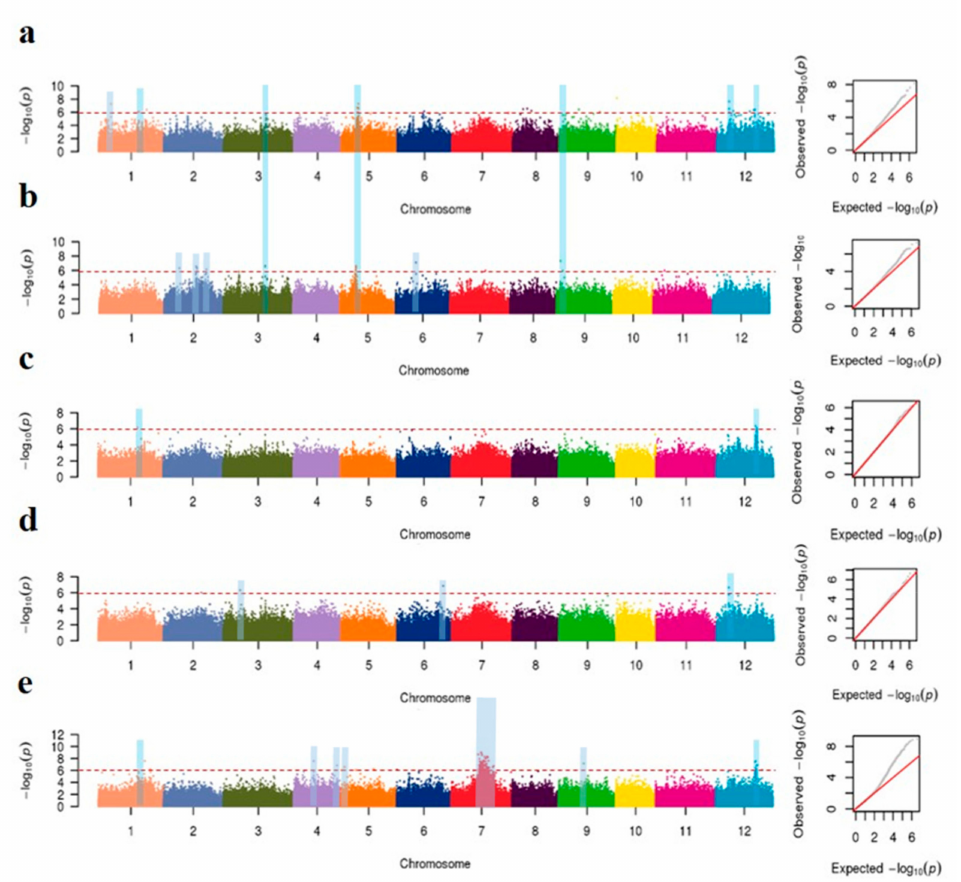
Figure 4. Genome-wide association studies for mesocotyl length among three culture media. Manhattan plots and Quantile-quantile plots of mesocotyl lengths in sand culture ( a ), water ( b ) and soil culture with a sowing depths of 2 cm ( c ), 4 cm ( d ) and 6 cm ( e ), respectively. Negative log 10 -transformed p values from a genome-wide scan are plotted against position on each of 12 chromosomes. The red horizontal dashed lines indicate the genome-wide significance threshold. Blue stripes show important signals in di ff erent